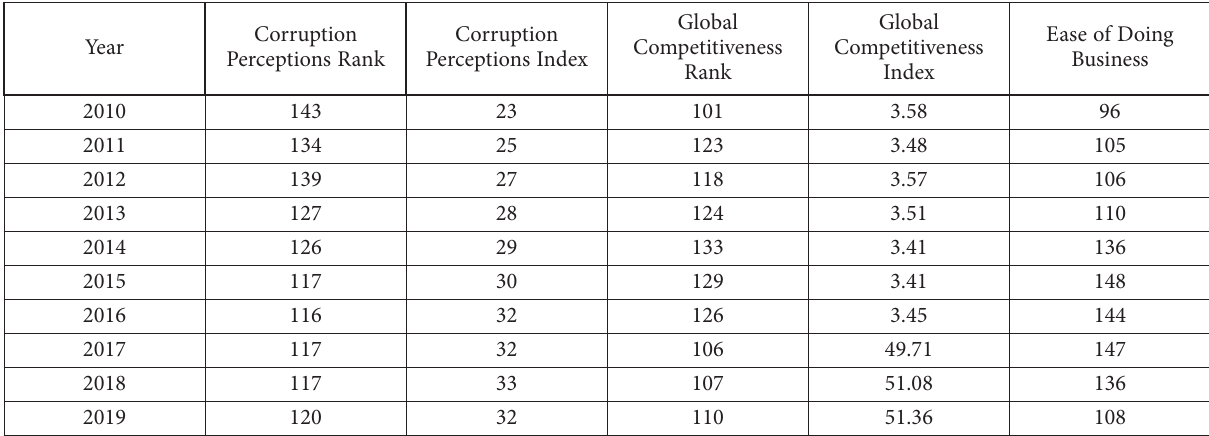
Table 4. Transparency and competitiveness in Pakistan (source: (a) Corruption Perceptions Rank and Corruption Perceptions Index from Transparency International, n.d.; (b) Global Competitiveness Rank and Global Competitiveness Index from World Economic Forum, 2019; (c) Ease of Doing Business from the World Bank,